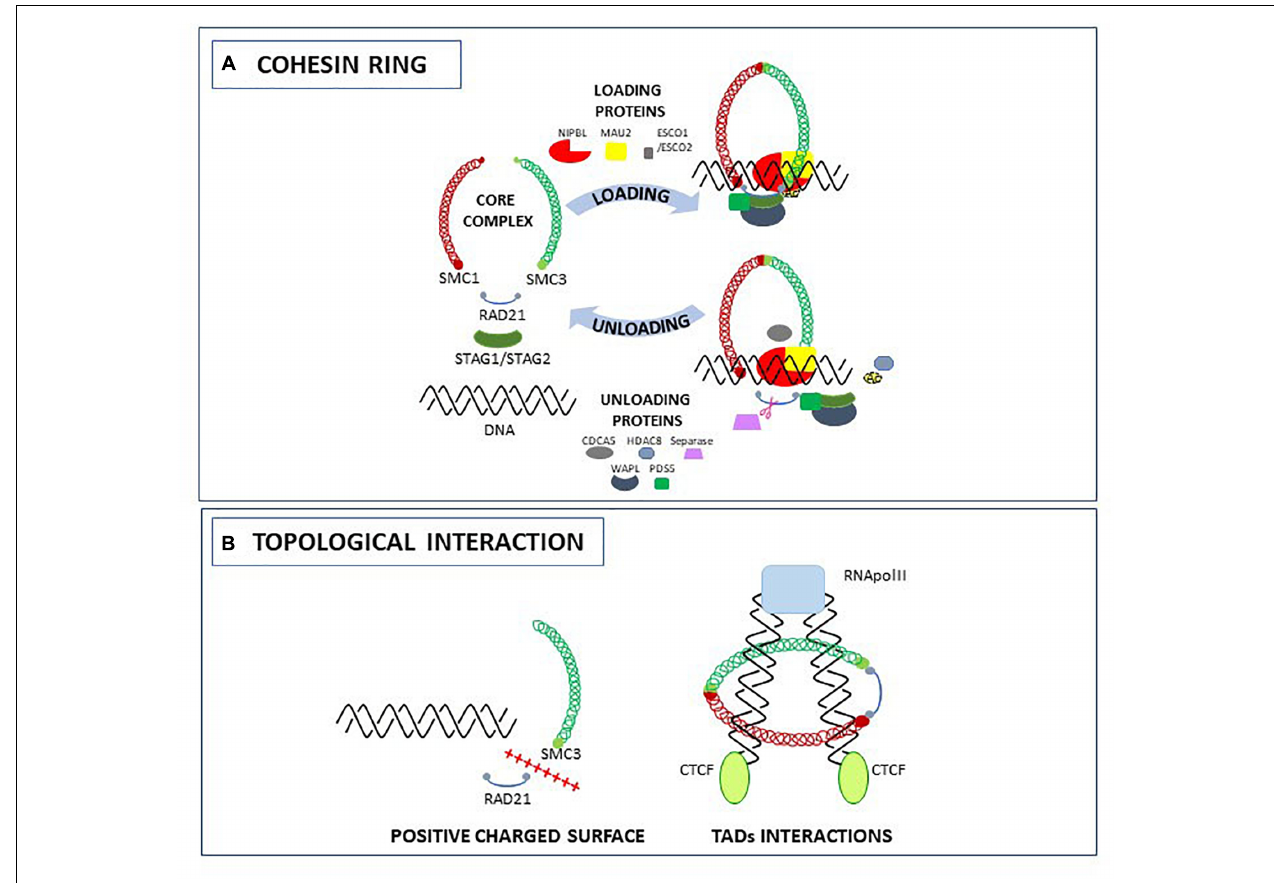
FIGURE 1 | The cohesin complex and accessory proteins: structure (A) and topological interactions with the DNA (B) .